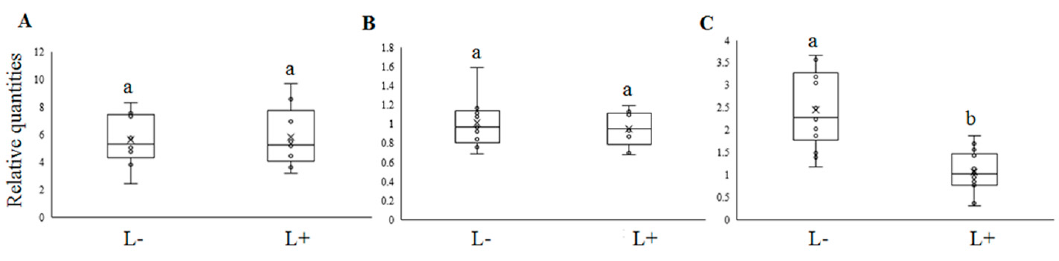
Figure 3. Relative quantities of Sodalis ( A ), Spiroplasma ( B ) and BtDNV (C) inside CLso-infected (L+) and uninfected (L-) psyllids. Different lowercase letters indicate significant differences of means ( p < 0.001).